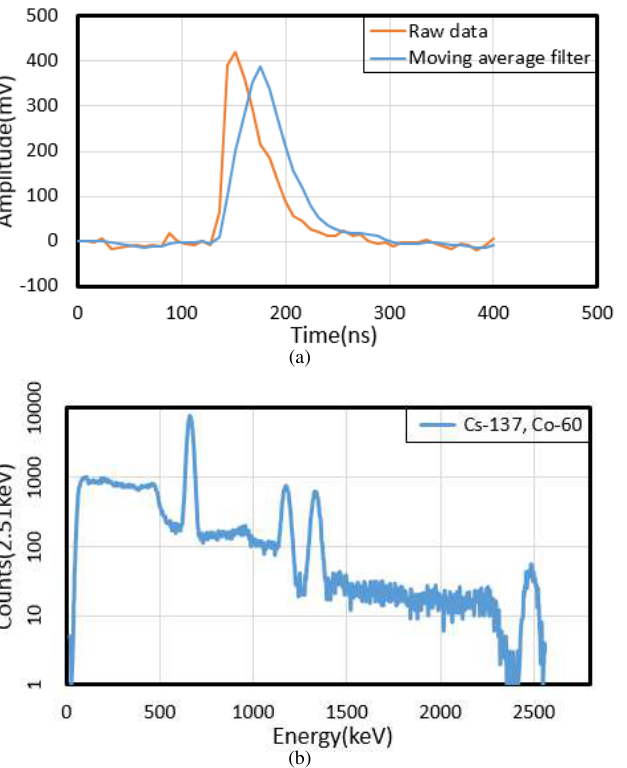
Fig. 7. Radiation pulse(a) and X-rays spectrum(b) with a HPGe detector.